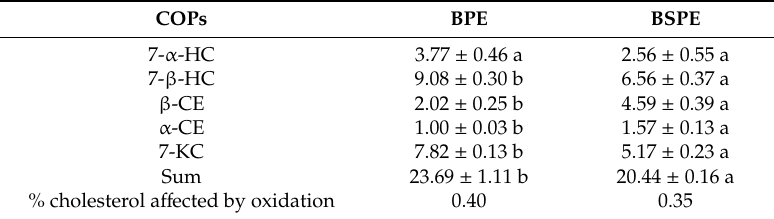
Table 5. COPs content ( µ g / g fat) BPE and BSPE egg